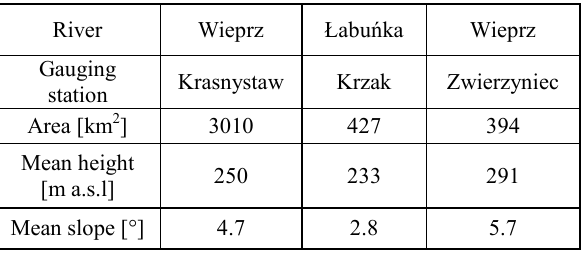
Table 1. Chosen characteristics of gauged catchments.